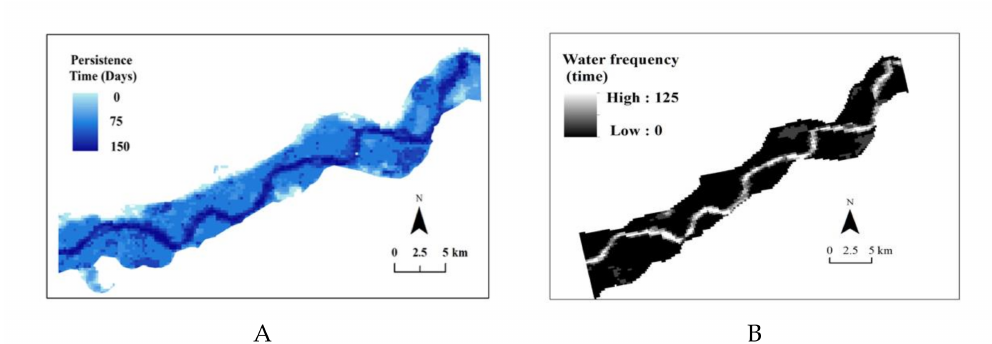
Figure 3. Spatiotemporal distribution patterns of water persistence time and frequency. ( A ) Map of floodplain water inundation persistence time map in the study area from 1 November 2014 to 31 March 2015. ( B ) Pixel-based water frequency images in the study area from 2010 to 2015 (from 1 April to 1 November in each year).